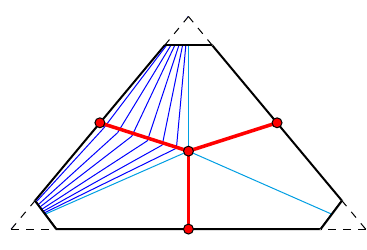
Figure 4 . The compactified cell e ∆ G for the sunrise graph. The blue lines indicate the fibers of , the cyan tripod is the fiber over the central 0-cube C π G : e ∆ G → S G over the cube C e 2